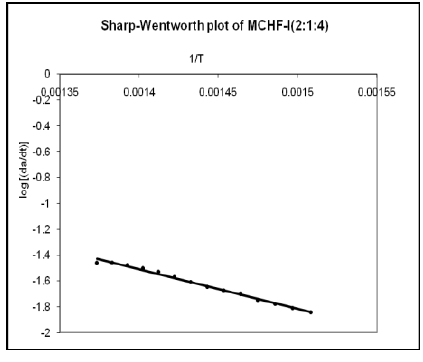
Figure 6: (a) FC plot. b) SW